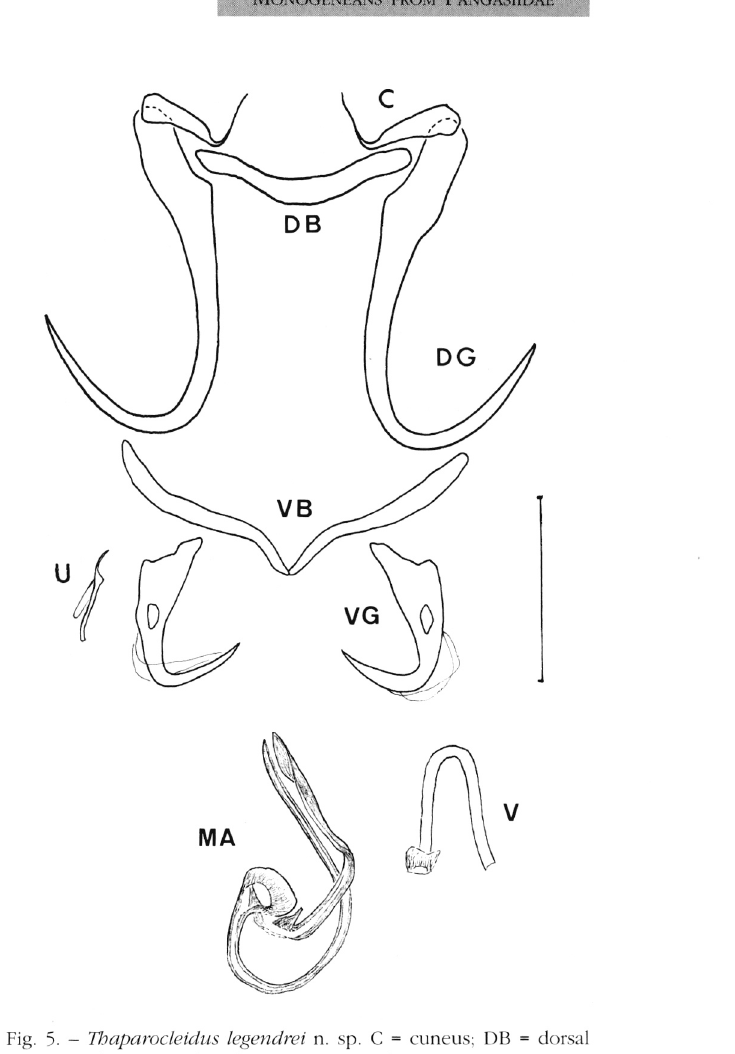
Fig. 5. - Thaparocleidus legendrei n. sp. C = cuneus; DB * dorsal transverse bar; DG = dorsal gripus; MA = male apparatus; VB = ven­ tral transverse bar; VG = ventral gripus; V = vagina; U = uncinulus. Bar = 30 pm.